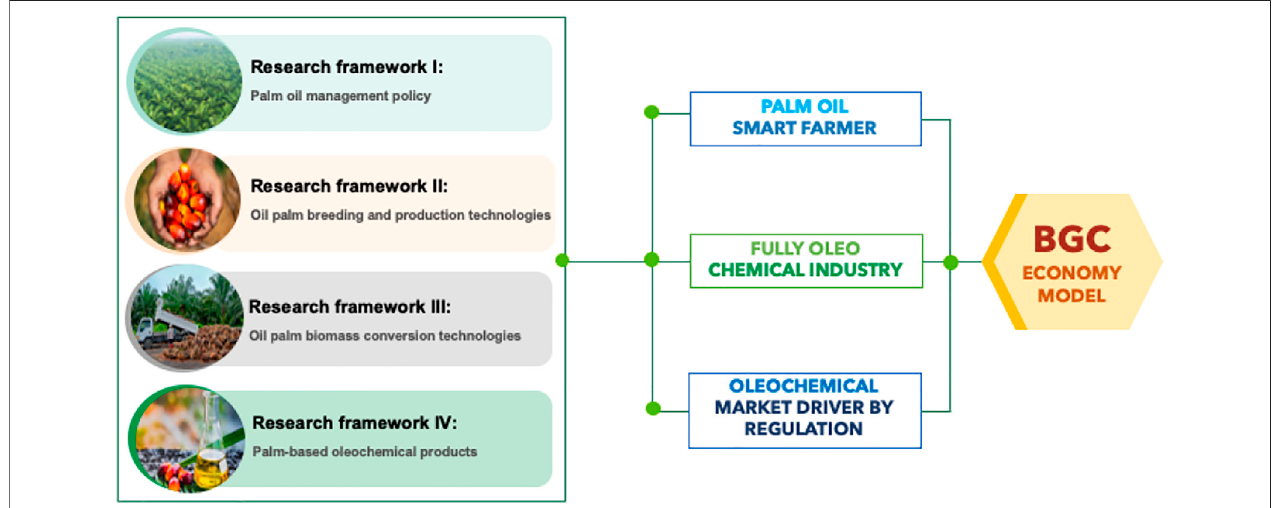
FIGURE 3 | Schematic diagram for the future research framework palm oil supply chain in